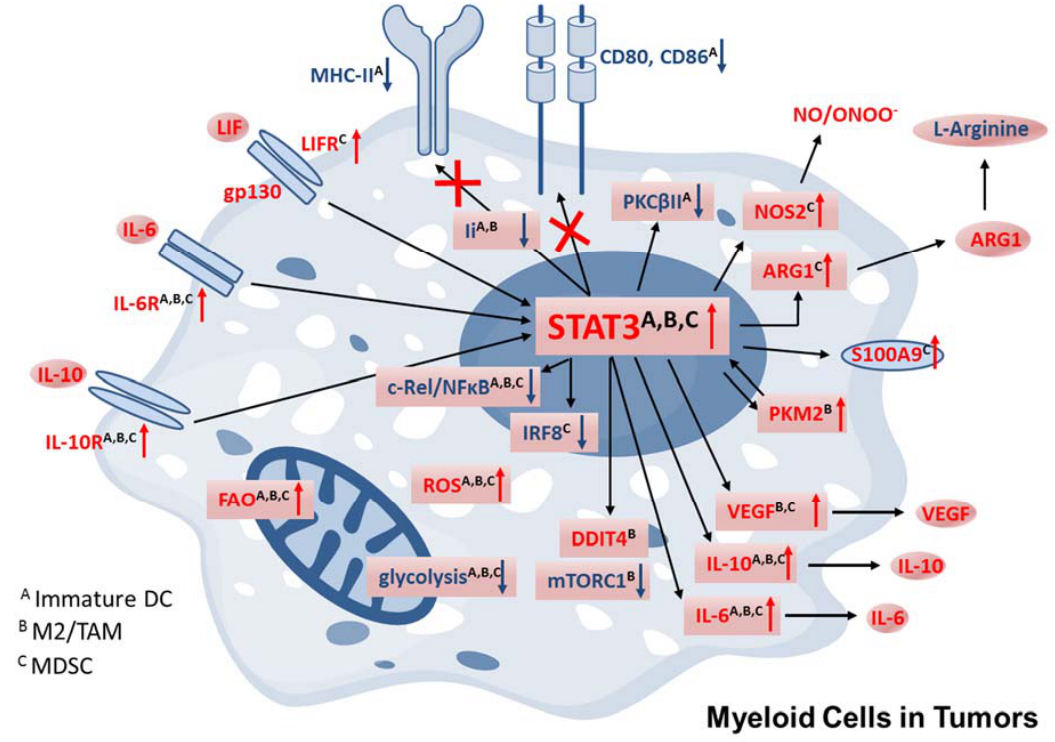
Figure 2. STAT3 orchestrates the immunosuppressive activity of tumor-associated myeloid cells. As indicated by black arrows, persistent activation of STAT3 in myeloid cells in the tumor microenvironment regulates in a positive (red arrows) or negative (blue arrows) manner a number of effector molecules involved in cellular metabolism as well as immunosuppression. The blocked expression of MHC ‐ II, CD80 and CD86 were indicated by red crosses. Some of these mechanisms are common, while others are specific to different myeloid cell subtypes, as indicated in the figure description.